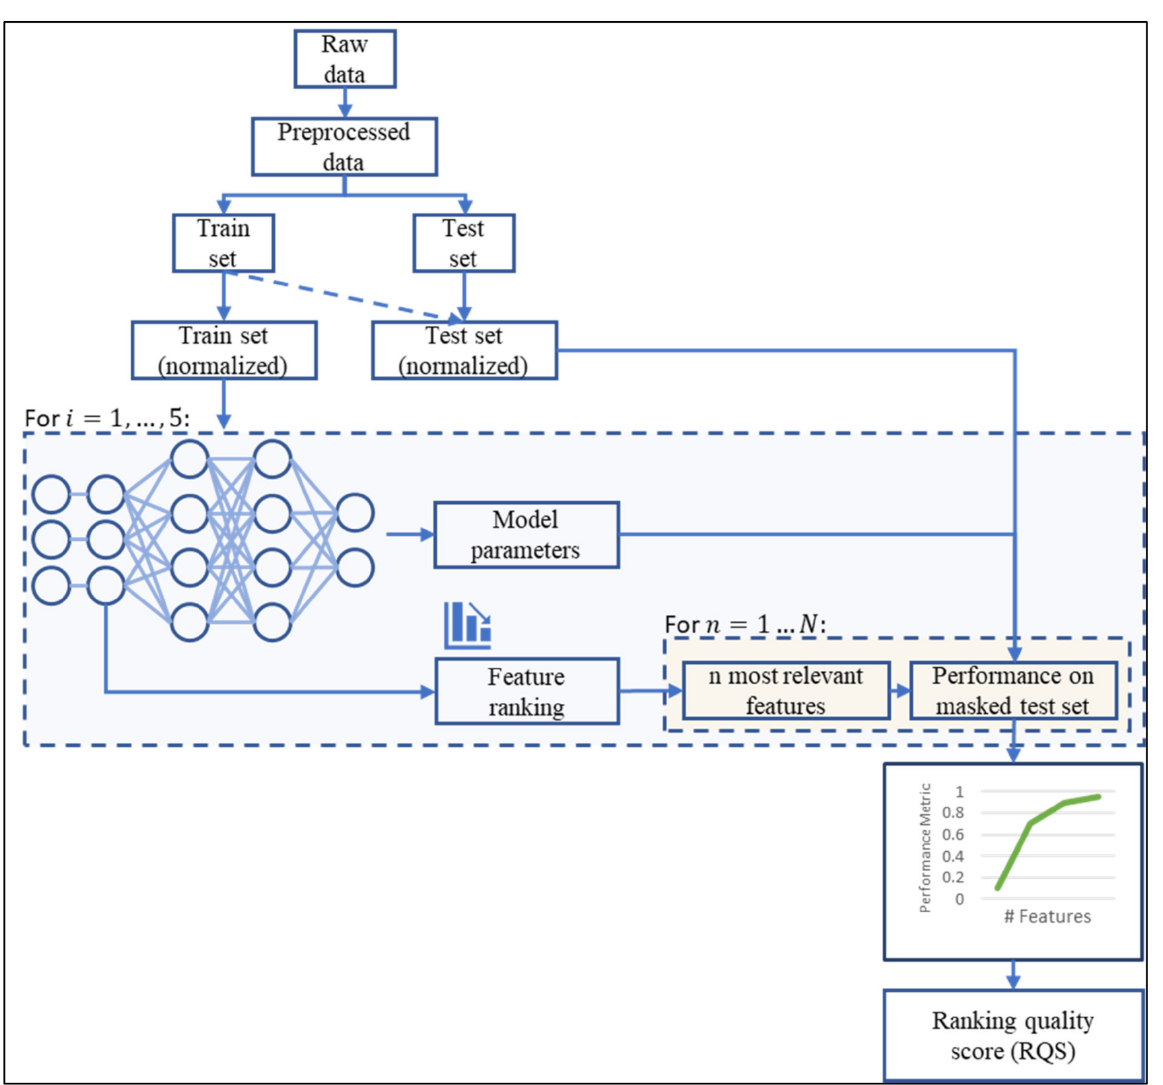
Figure 6. Proposed methodology block diagram for ranking quality